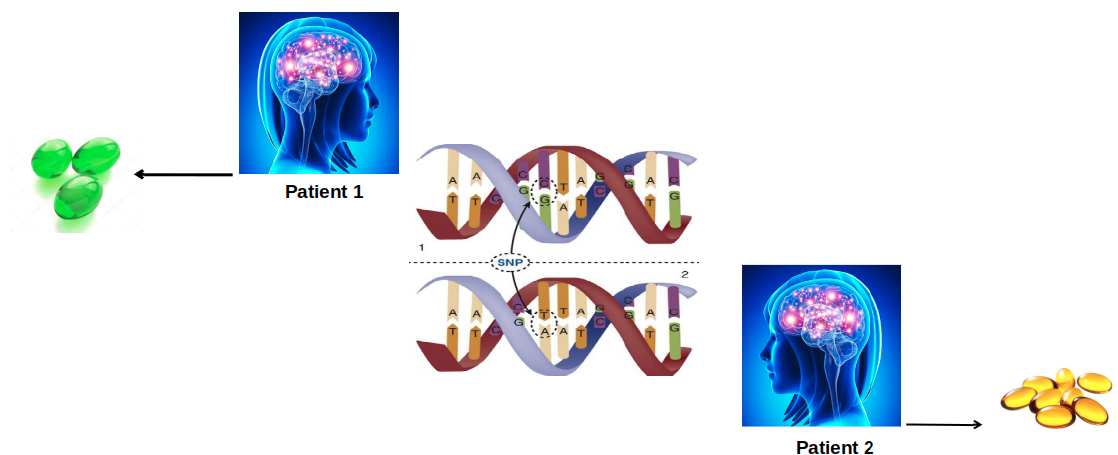
Figure 6. The effect of SNP on drug response. A single nucleotide variation causes two patients with the same disease to be prescribed differently as indicated by different colors and numbers of